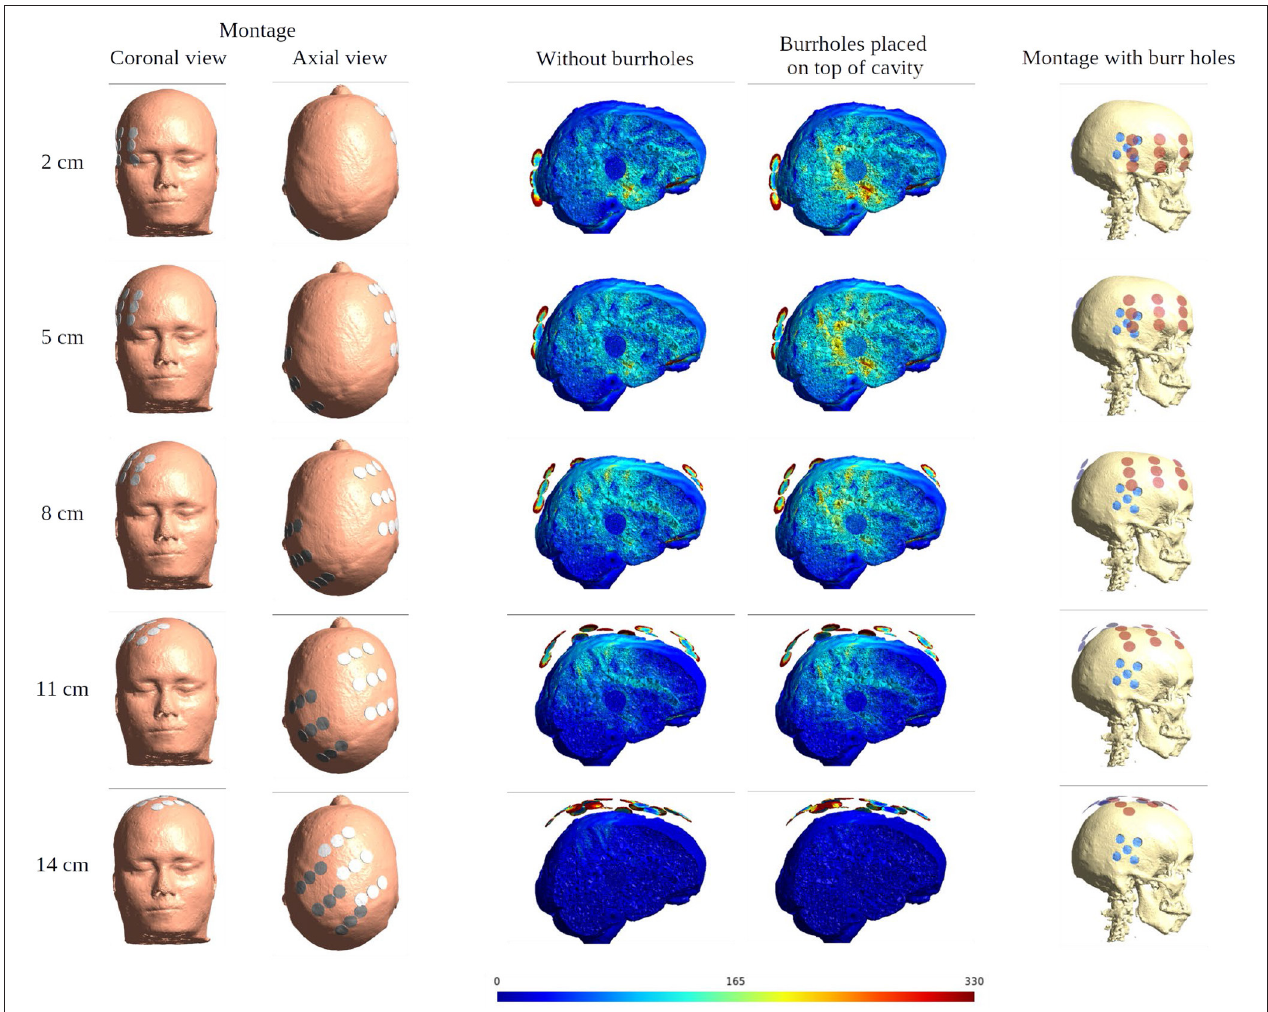
FIGURE 11 | Effect of SR surgery with the moving of the array pair toward the central craniocaudal z -axis. The burr holes for the SR surgery are placed directly over the resection cavity and residual tumor. The first two columns show the electrode montage in different views. The following two columns give the sagittal view of the electric field intensities with and without burr holes. The last column presents the overlay of the electrode array (red) and the burr holes (blue) for the SR surgery